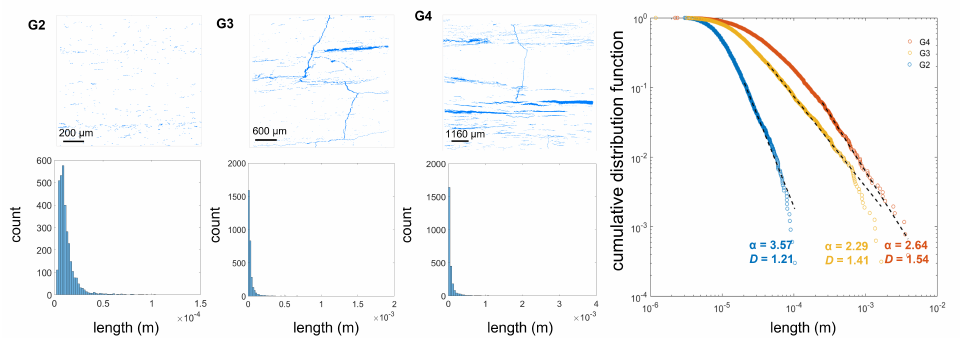
Figure 3. Segmented fracture networks, histograms, and cumulative distribution function for 2D shale rock images corresponding to samples G2, G3, and